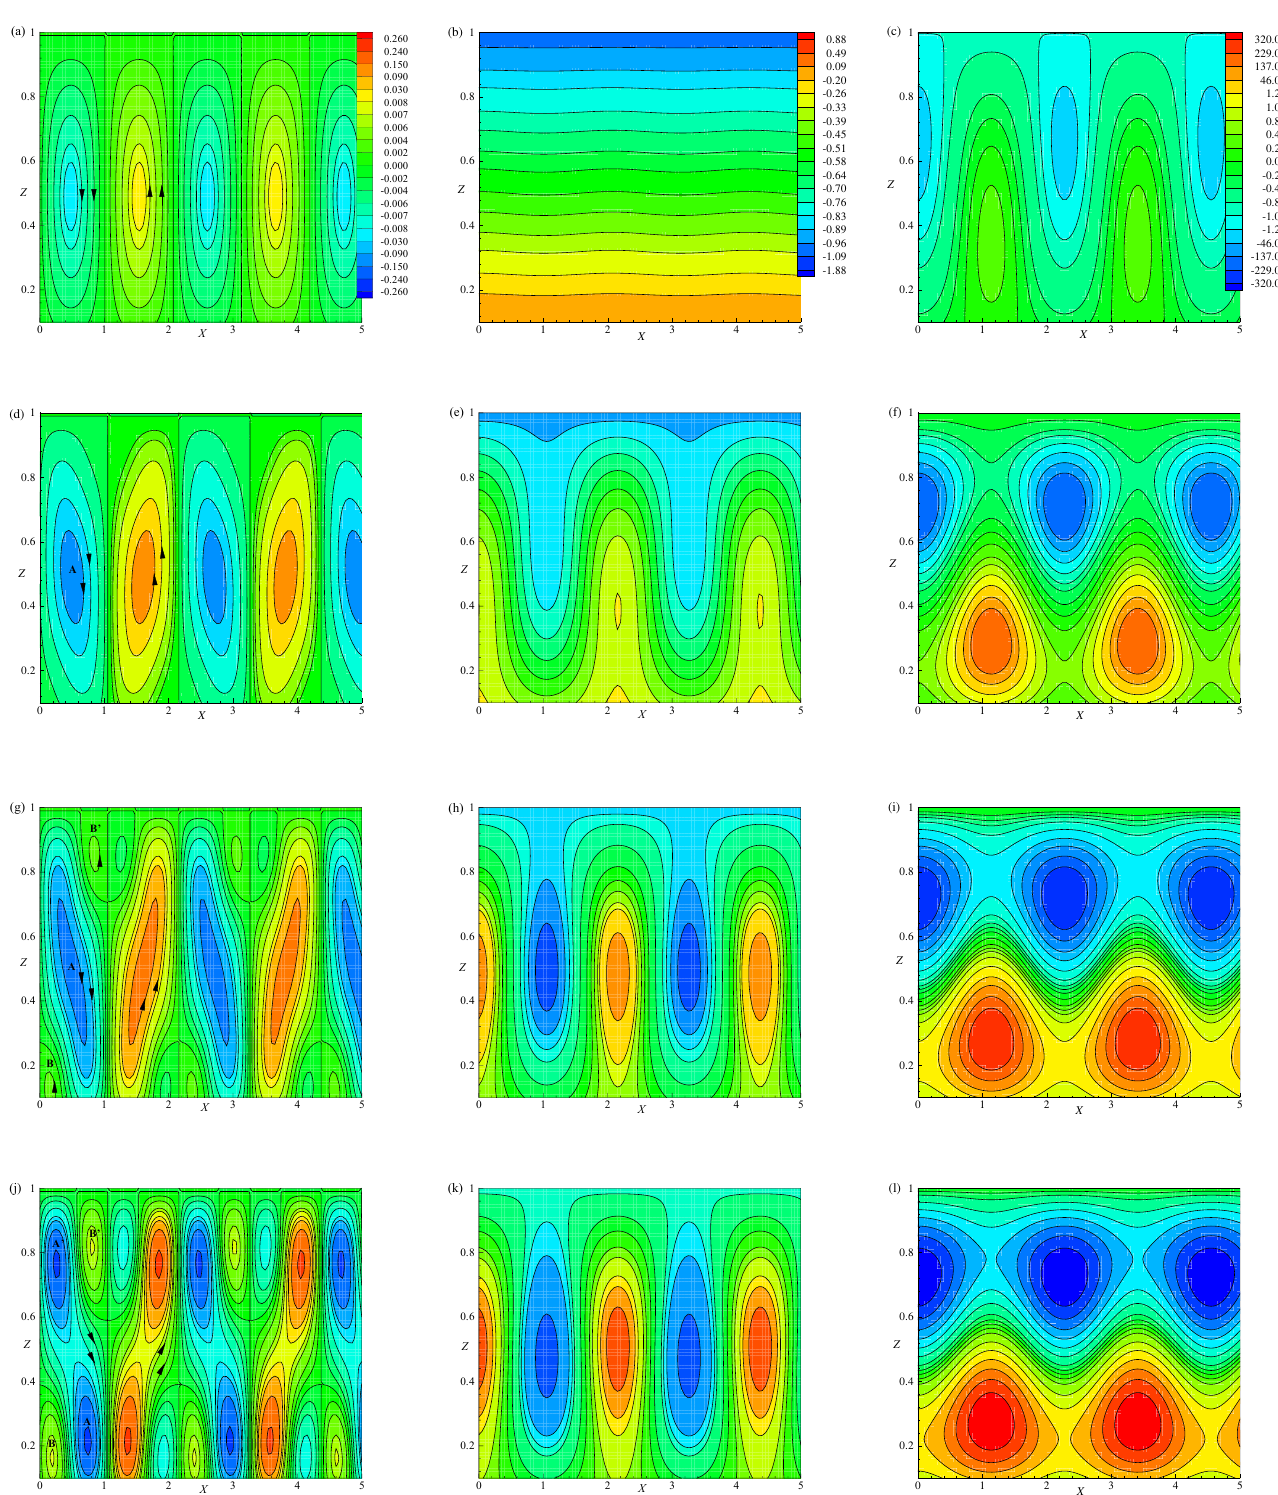
Figure 8. Streamlines ( left ), isotherms ( middle ) and isoconcentration lines ( right ) for Le = 0.06, ψ = − 0.01, χ = 0.4, t = 0.1 with R (cid:39) R co ( a – c ), R =3 R co ( d – f ), 5 R co ( g – i ), 7 R co ( j – l ). Figure 9 illustrates the streamlines, isotherms and isoconcentrations for distinct values of ψ with a fixed set of other parameters, say, R = 3 R co , Le = 0.06, χ = 0.4 and t = 0.1. Figure 9a–c are plotted for ψ = − 0.02. In Figure 9a the primary concentric roll